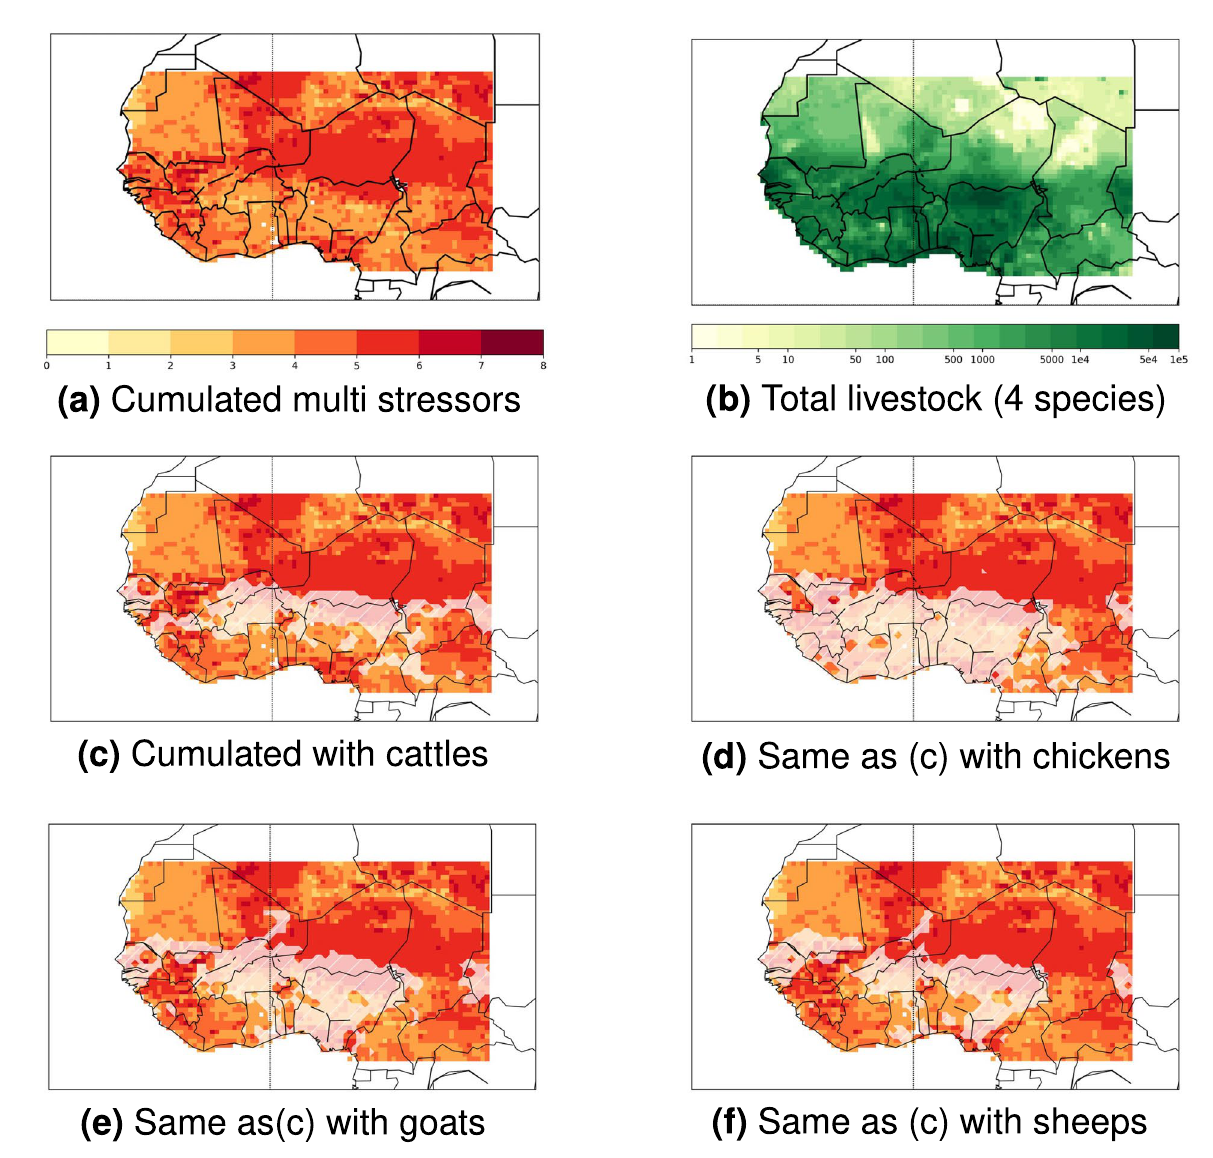
Figure 2. Spatial distribution of cumulated multiple stressors and livestock exposure. The cumulated significance is obtained from the addition of each of the eight stressor indicator spatial distributions that gives a value of 1 if the impact future change is ≥ than one standard-deviation (std) calculated over the impact values in the 1979–2005 period, and a value of 0 if not (Figure S4). A value of 8 here indicate 8 combined significant future changes of the stressors, whereas a 0 indicate no significant stressor changes. White areas indicate grid points where there is at least 1000 heads of the corresponding livestock (absolute livestock numbers are displayed in Figure